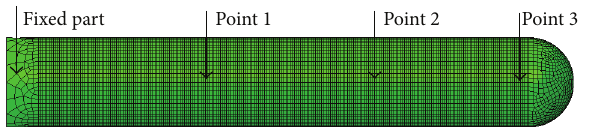
Figure 6: Analytical